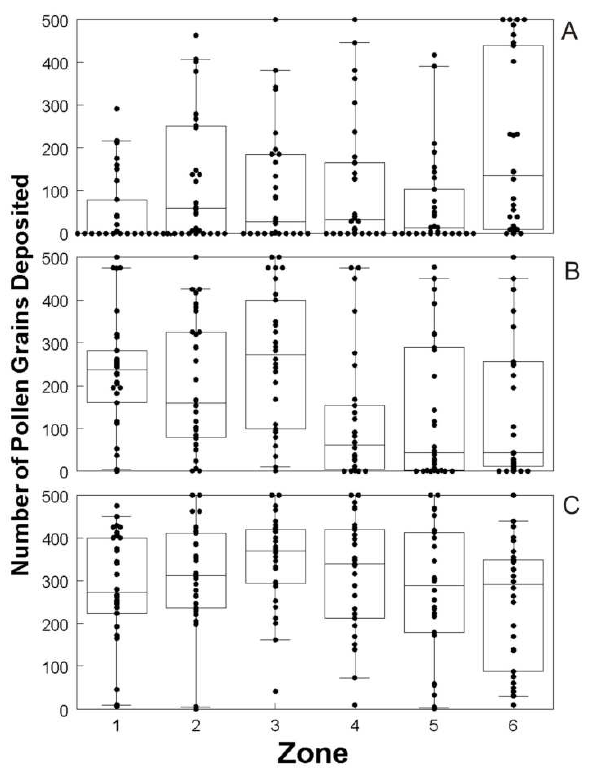
F IGURE 4. Pollen deposition per whole flower (box and whisker plot, central horizontal line showing mean, box = 25 th and 75 percentiles, whiskers = 5 th and 95 th percentiles) during A) early, B) mid, and C) late flowering of 2000. Zone 1 is closest to Osmia nests, Zone 6 most distant. Significant differences were observed among stages of flowering but not among the zones; a significant interaction between stage of flowering and zone was observed (see text).